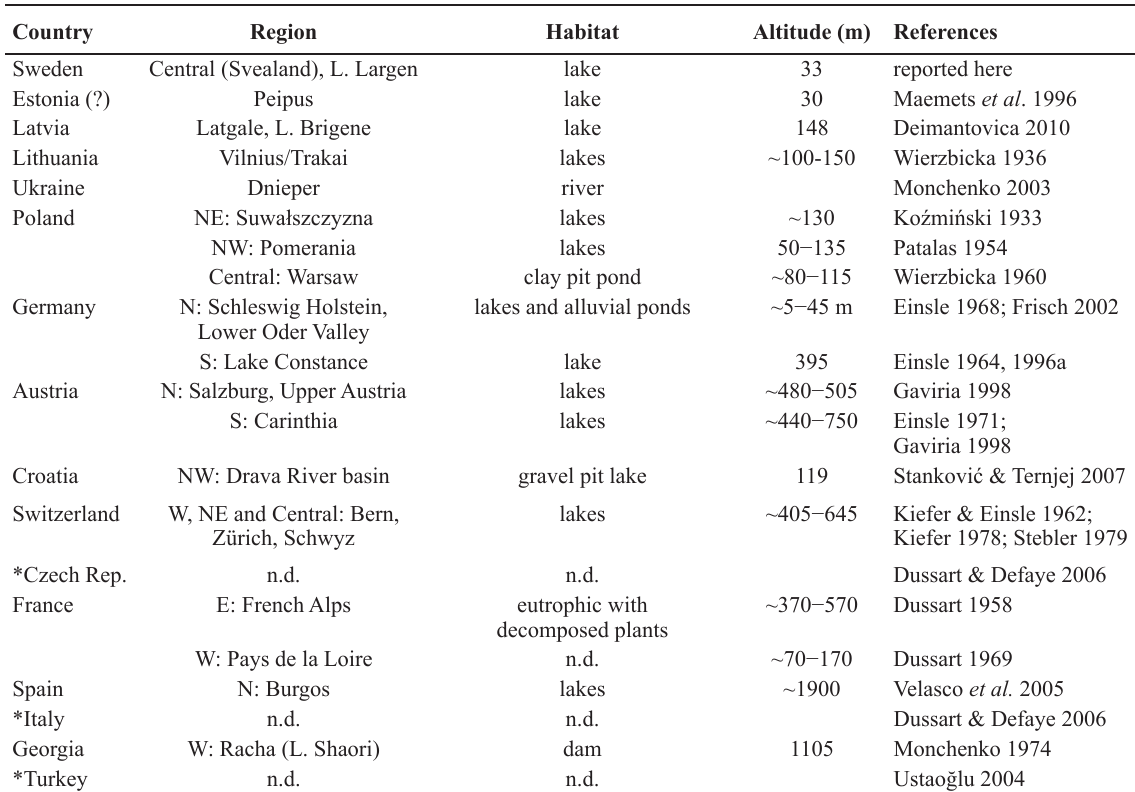
Table 4. overview of the published records of Cyclops bohater koźmiński, 1933. For comments on the data see “Discussion”. ? = dubious identification according to maemets et al. 1996; * = world-catalogue or regional checklist reports without specific information on the localities and authors; n.d. = no data; e = east; n = north; s = south; W =